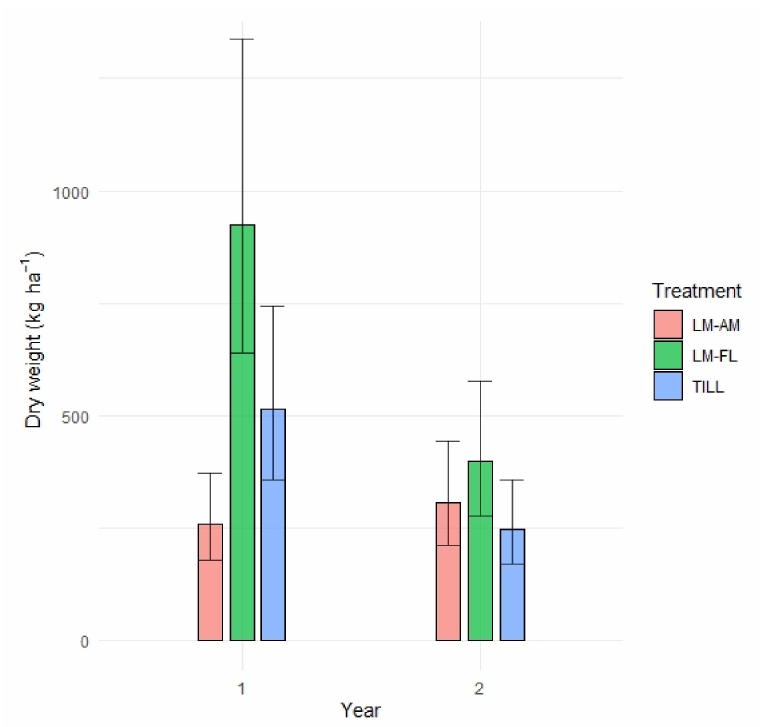
Figure 3. Effect of treatments (TILL, LM-FL, LM-AM) and years (1 is 2019, 2 is 2020) on the dry weight of the total aboveground biomass of weeds collected in cauliflower at harvest time. Error bar represents the upper and lower limits of the 95% confidence interval.